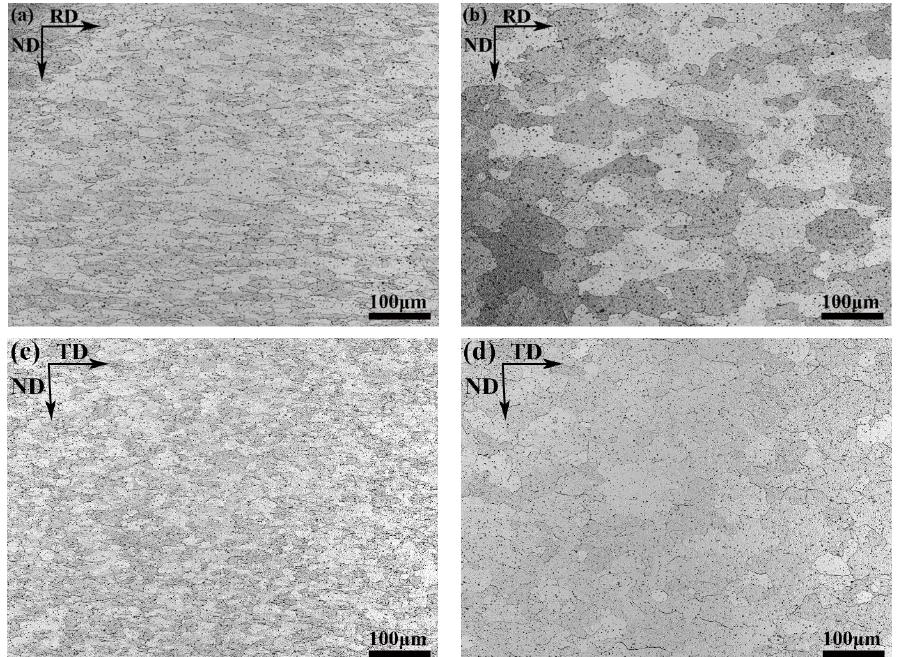
Figure 1. Microstructure of WY50 plate: rolled sample ( a , c ) and fully recrystallized sample ( b , d ).